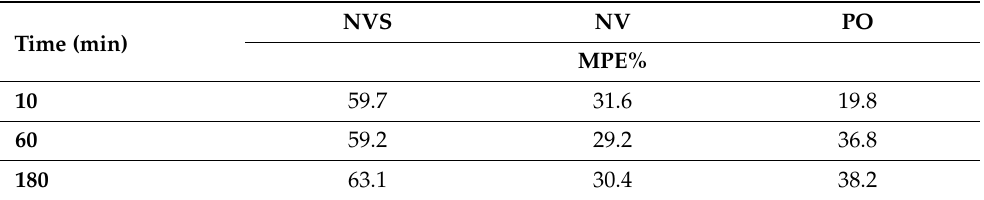
Figure 5. Mean writing counts in mice treated with ( A ) Ketoprofen nasal nanovesicular system (KET-NVS), vs. oral drug administration (KET-PO), each at a dose of 11 mg/kg, 30 min prior to i.p. injection of acetic acid and compared to untreated mice, (n, 4/each group). ( B ) Butorphanol nanovesicular system (BUT-NVS), vs. water solution (BUT-WS), each at a dose of 0.15 mg/kg, 10 min prior to i.p. injection of acetic acid and compared to untreated control mice, (n, 5/each group). ( C ) Tramadol at a dose of 5 mg/kg in Nasal Nanovesicular carrier (TRA NVS), Nasal non-vesicular system (TRA NV), Oral preparation (TRA PO) and untreated mice 10, 60 and 180 min prior to i.p. injection of acetic acid; (n, 5/each group), mean ± SD. p < 0.05 for KET-NVS-treated group vs. KET-PO. p < 0.01 for KET-NVS-treated group vs. untreated control. p < 0.05 for BUT NVS vs. BUT PO, p < 0.01 for BUT NVS vs. untreated. p < 0.05 for TRA NVS vs. TRA PO, and TRA NV and untreated at all time points. Table 6. MPE% following administration of Tramadol nasal nanovesicular system (TRA NVS) to mice as compared to Nasal non-vesicular system (TRA NV) and Oral administration (TRA PO), each at a drug dose of 5 mg/kg, at various time points prior to pain